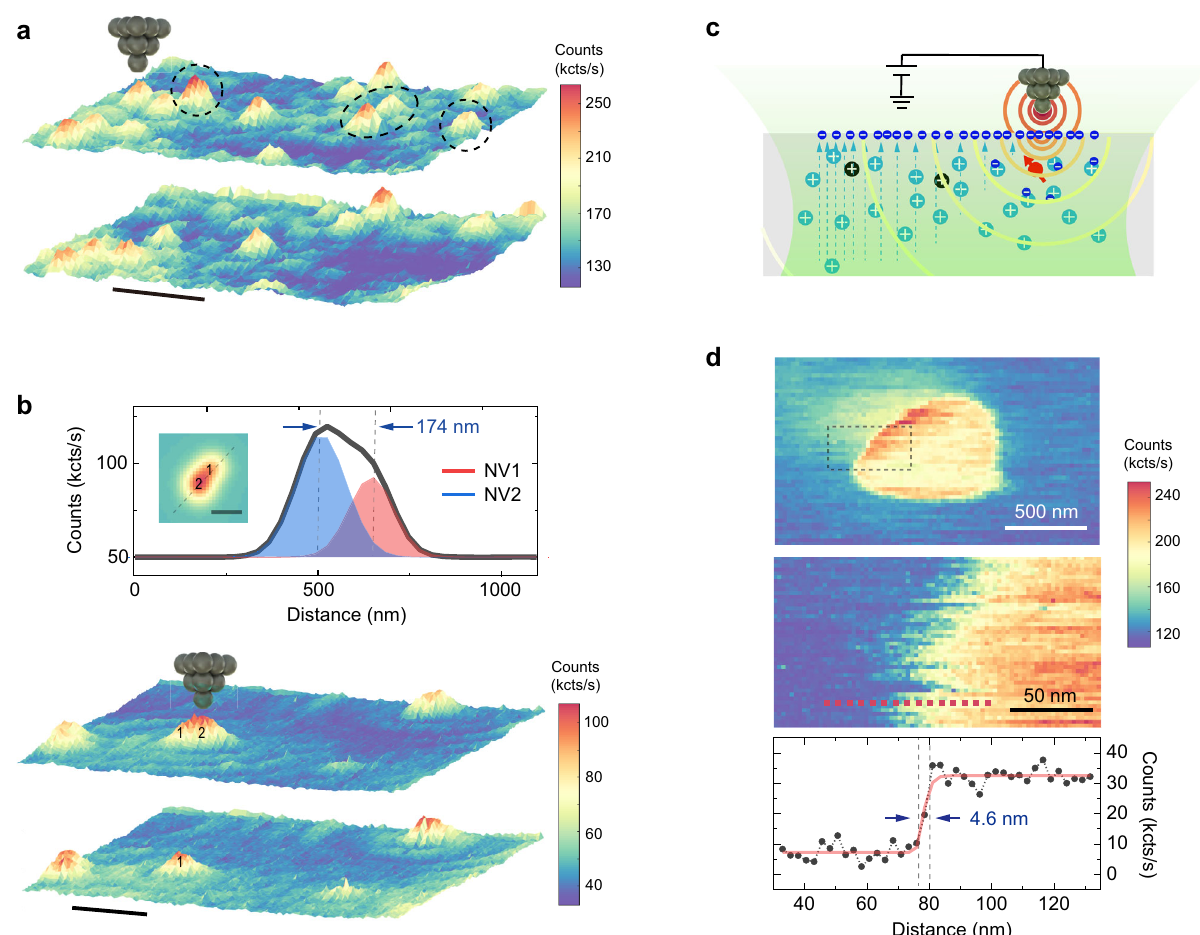
Fig. 5 Local charge-state control with high spatial resolution. a Confocal image showing highly ef fi cient charge-state control of arbitrarily selected NVs. The target NVs are denoted by the black dashed circles. Scale bar: 1 μ m. b Charge state control of a NV dimer with a separation beyond the diffraction limit. The manipulated NV is denoted by 2. Scale bar: 0.6 μ m. Upper panel: Line pro fi le across the dimer and the corresponding Gaussian fi t, yielding a separation distance of ~174 nm. Inset: Simulated confocal image of the NV dimer. Scale bar: 250 nm. c Schematic graph demonstrating the basic principle of charge- state transition imaging. The AFM tip with a high fi eld gradient is able to control the charge state of NV with high spatial resolution. The green shade denotes excitation laser, while the semi-circled curves denote electrostatic potential contour from the conducting tip. The dashed lines indicate the built-in electric fi eld. d Charge-state transition image of a single NV. Upper panel: A disk-like structure was obtained when scanning the metal tip with a high positive bias ( + 90 V). The edge of the disk re fl ects the NV + /NV 0 transition. Middle panel: The zoomed-in image as denoted by the black dashed rectangle in the upper panel. Lower panel: The pro fi le along the red dashed line depicted in the middle panel. After subtracting a linear slope, the line pro fi le was fi tted by a step function, yielding a spatial resolution of 4.6 nm for charge-state